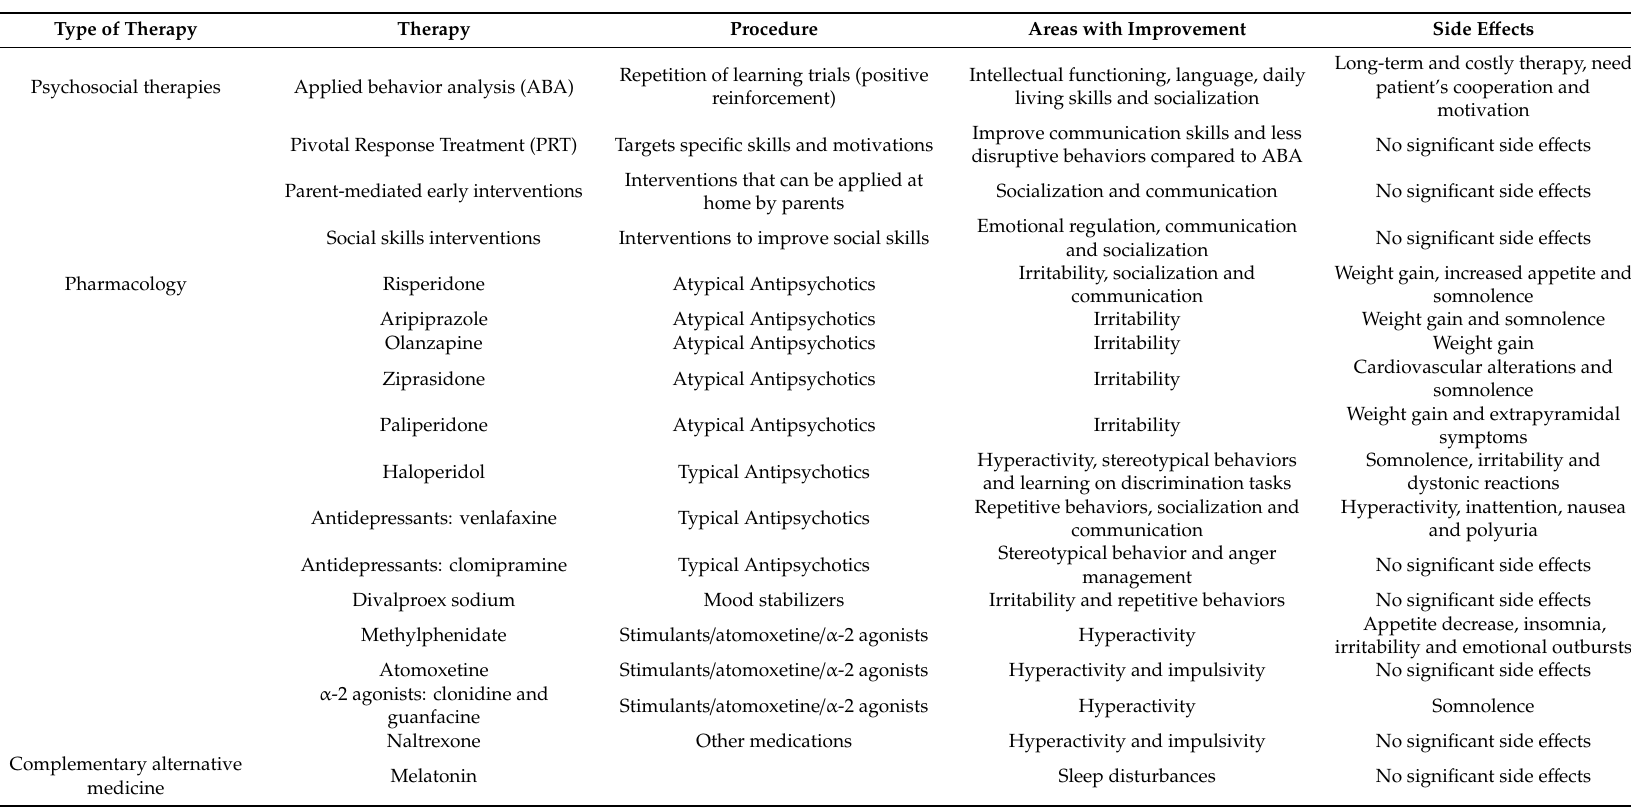
Table 2. Therapeutic options available to treat ASD symptoms. Available therapeutic approaches can be classified into three groups: psychosocial therapies, pharmacology and complementary alternative medicine. In the table below, it can be found a list of the available therapies divided into these three categories, including a brief explanation on which ASD symptoms can be ameliorated by their use, as well as their previously reported side e ff ects